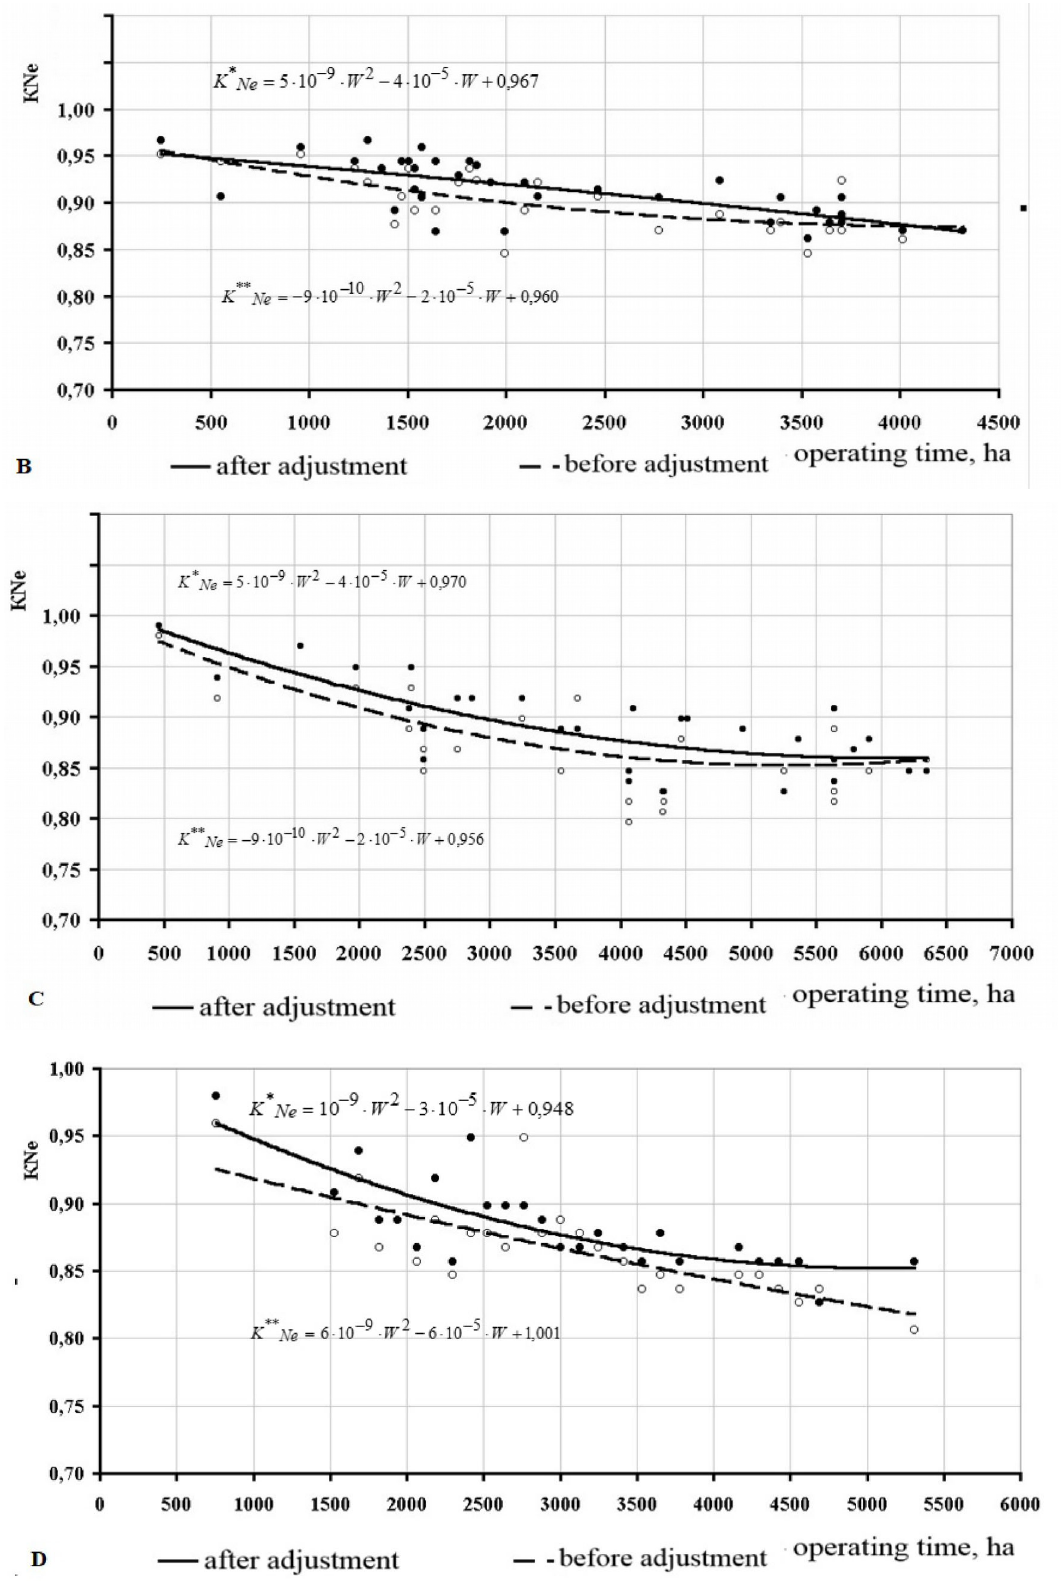
Figure 1. Dependence of the value of the coefficient K on the operating time of tractors: a) ДТ -75 before overhaul; b) Ne ДТ -75 after overhaul; c) T-402 before overhaul; d) T-402 after overhaul; *before adjustment; **after